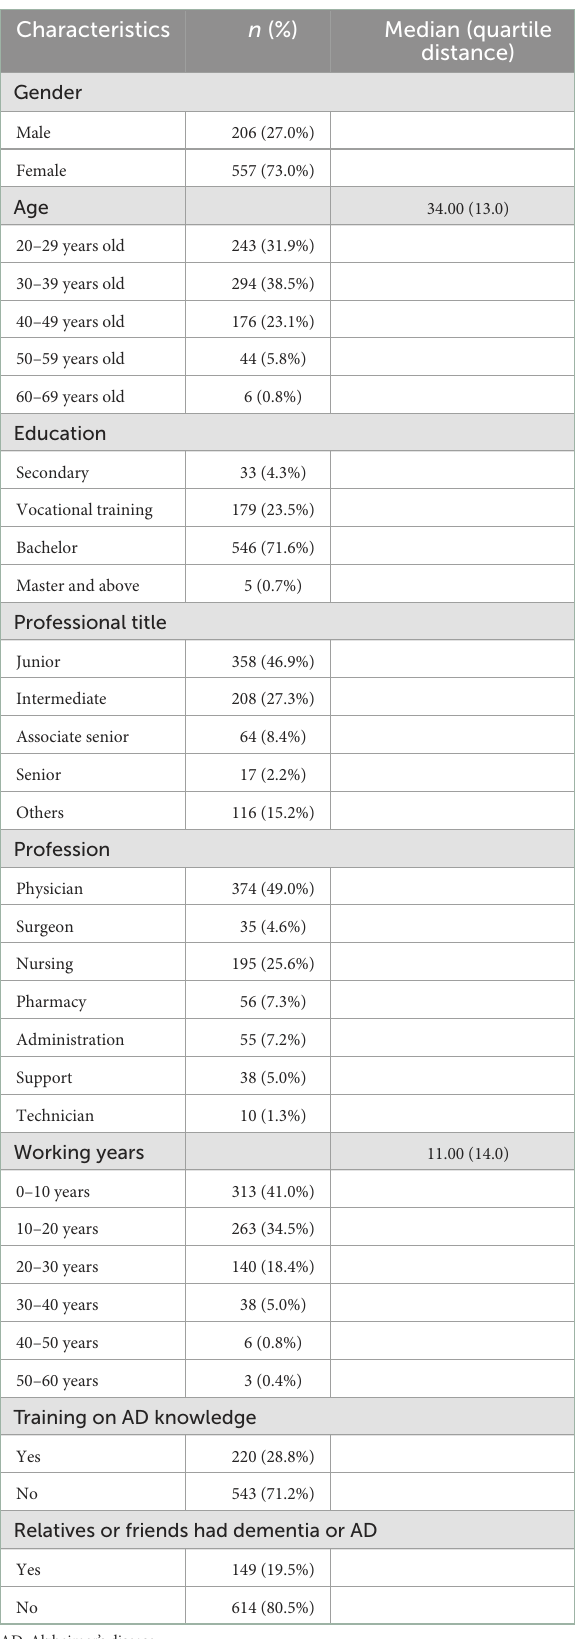
TABLE 1 Sociodemographic characteristics of the sample.